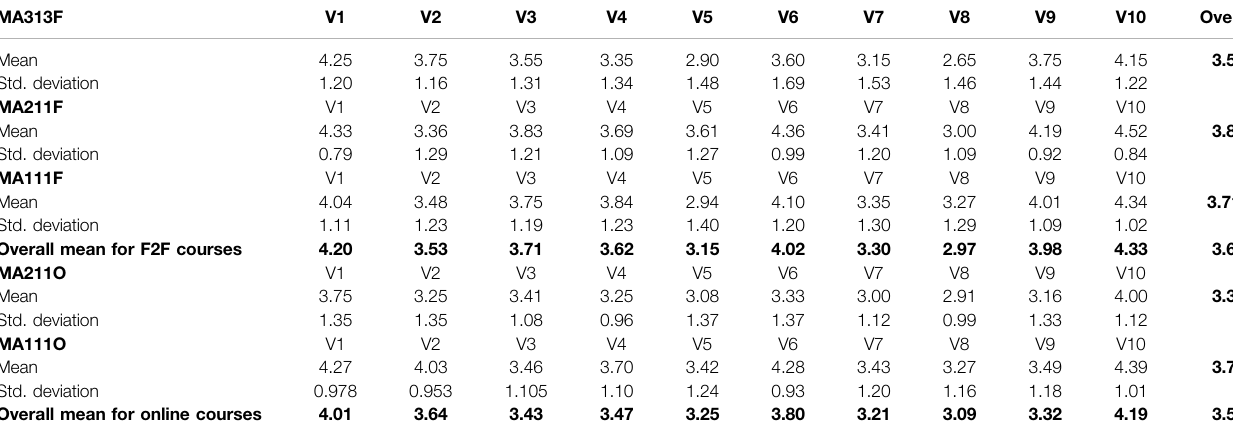
TABLE 4 | Students ’ use of the ATs for the mathematics courses. The highlighted shows the mean responses for each course with each AT used in the courses. MA313F V1